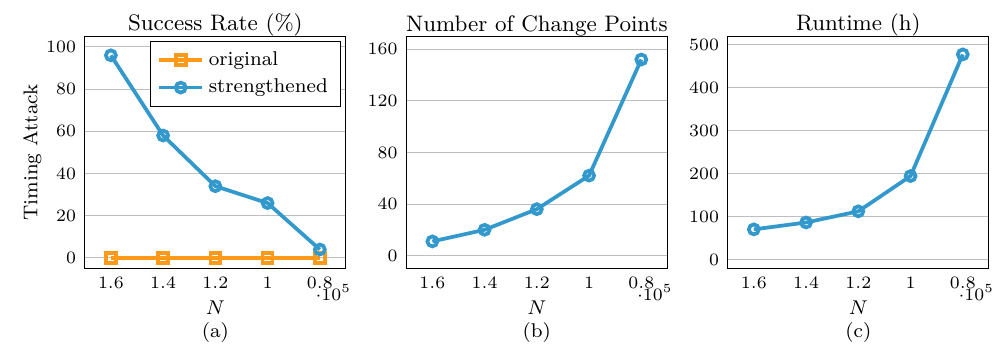
Figure 5: (a) Success rate of the original timing attack and of the attack strengthened by the proposed methodology. (b) Average number of change points detected. (c) Average runtime of the successful strengthened attacks. All these quantities are presented as a function of the number N of execution time measurements, analyzed by the